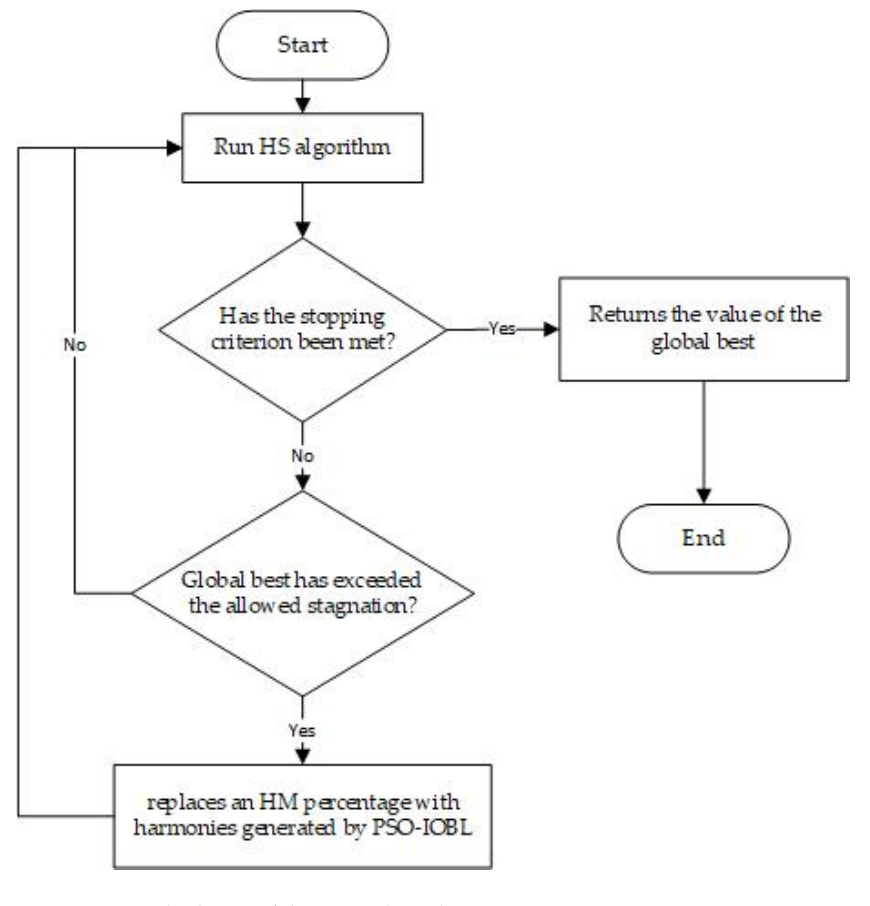
Figure 1. General scheme of the HHS algorithm.